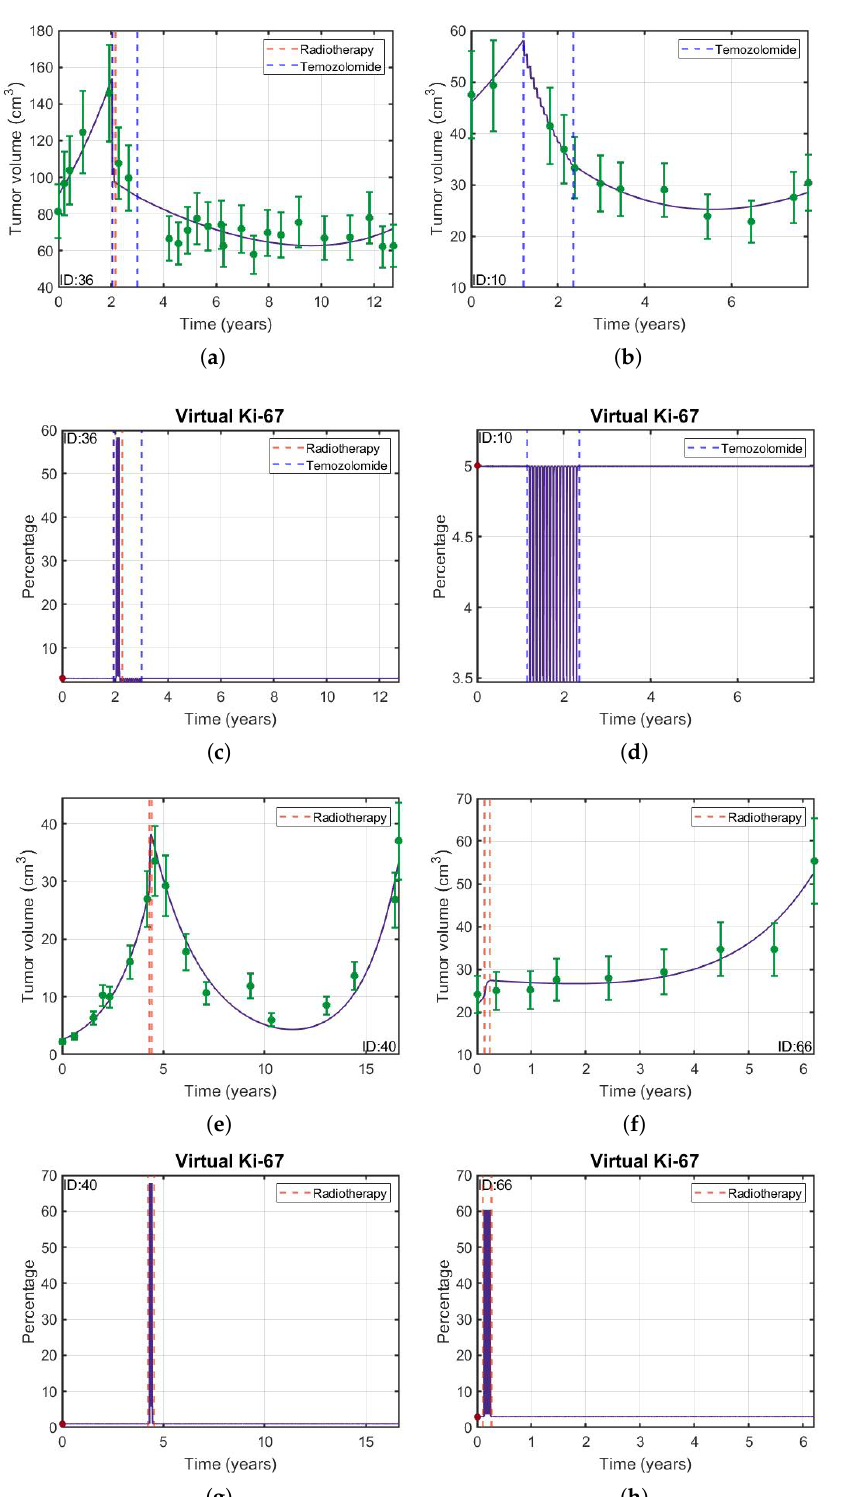
( h ) Figure 2. ( a , b , e , f ) Examples of longitudinal volumetric dynamics (green circles) with their respective 18 % error bars (green vertical lines) and best fits obtained using Equation (1) (solid purple line). Data shown correspond to patients 10,36,40 and 66 (green circles). ( c , d , g , h ) Time evolution of 100 P ( t ) / ( P ( t ) + Q ( t )) interpreted as virtual (solid purple line) and initial (red circle) Ki-67 labeling index. The vertical dashed lines indicate the onset and end times of the treatments received by each patient (either RT, QT or